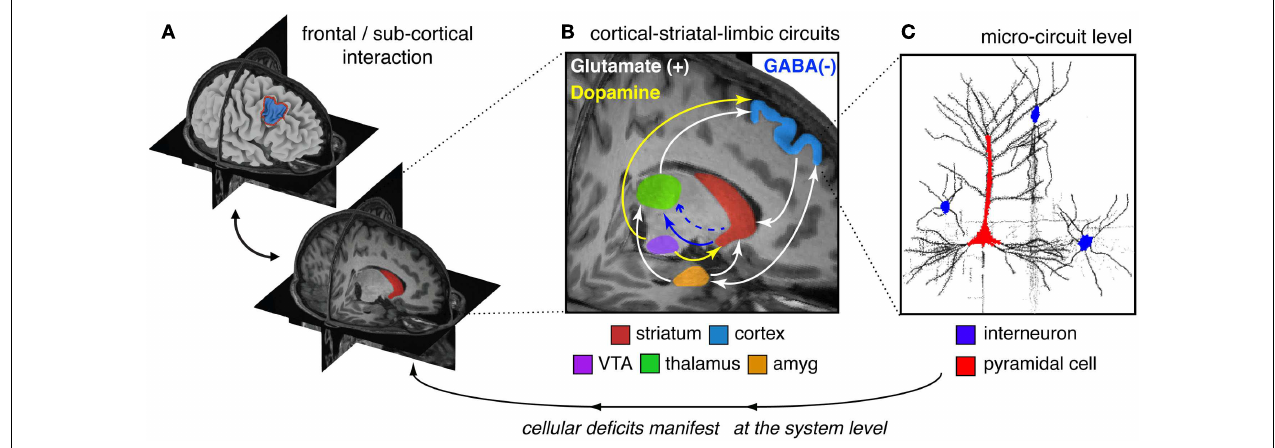
interplay between interacting neurotransmitter systems in cortico-striatal-thalamic loops that may be compromised in schizophrenia (Carlsson et al., 2001; Coyle, 2006). (C) Based on emerging findings from basic animal (Lewis et al., 2004;Yizhar et al., 2011), post-mortem (Lewis et al., 2005, 2012), and pharmacological studies (Krystal et al., 2003), there is an increasing understanding of micro-circuit abnormalities that may be at play in schizophrenia (Marin, 2012). It may be possible that abnormalities in the balance of excitation/inhibition in cortical microcircuitry contribute to downstream system-level disturbances that encompass distributed circuits and neurotransmitter systems. One leading hypothesis postulates an imbalance between cortical excitation and inhibition between pyramidal cells (red) and interneurons (blue), producing a state of “disinhibition,” which may in turn affect regional and system-level function (Yizhar et al., 2011). Considering effects across all of these levels will be critical to mechanistically understand complex schizophrenia phenomenology and symptom-level